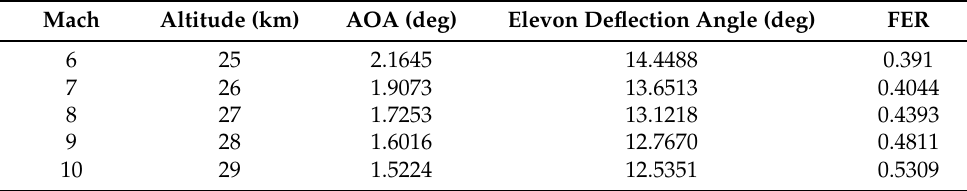
Table 2. Trim values of hypersonic